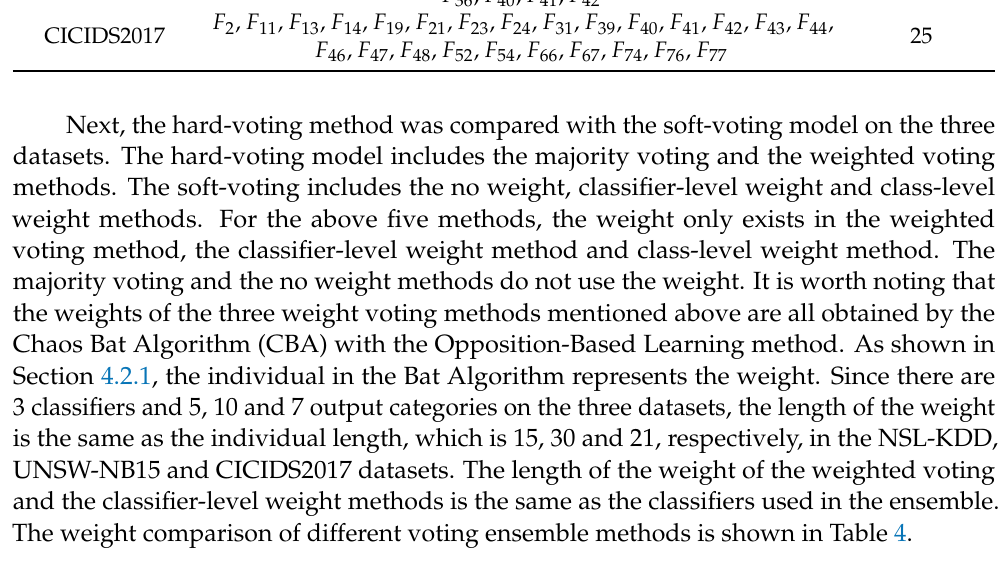
Table 3. The selected features based on the chi-square filtering technology.